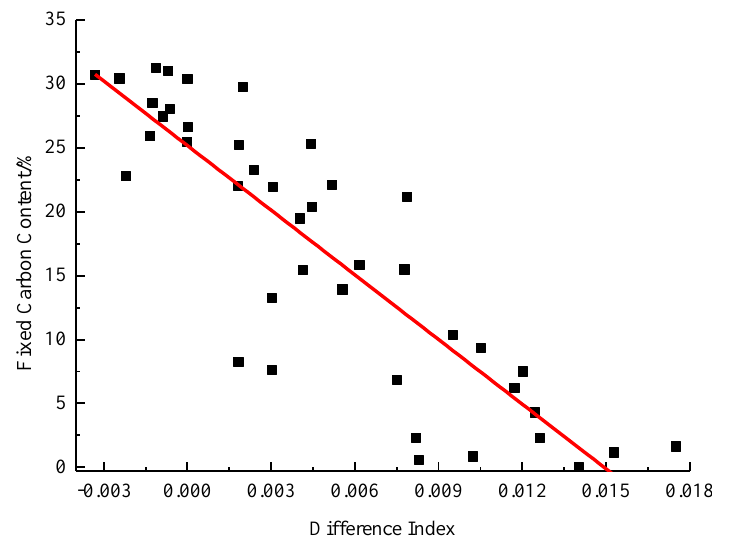
Figure 6. Fitting results of the fixed carbon content and ratio index.